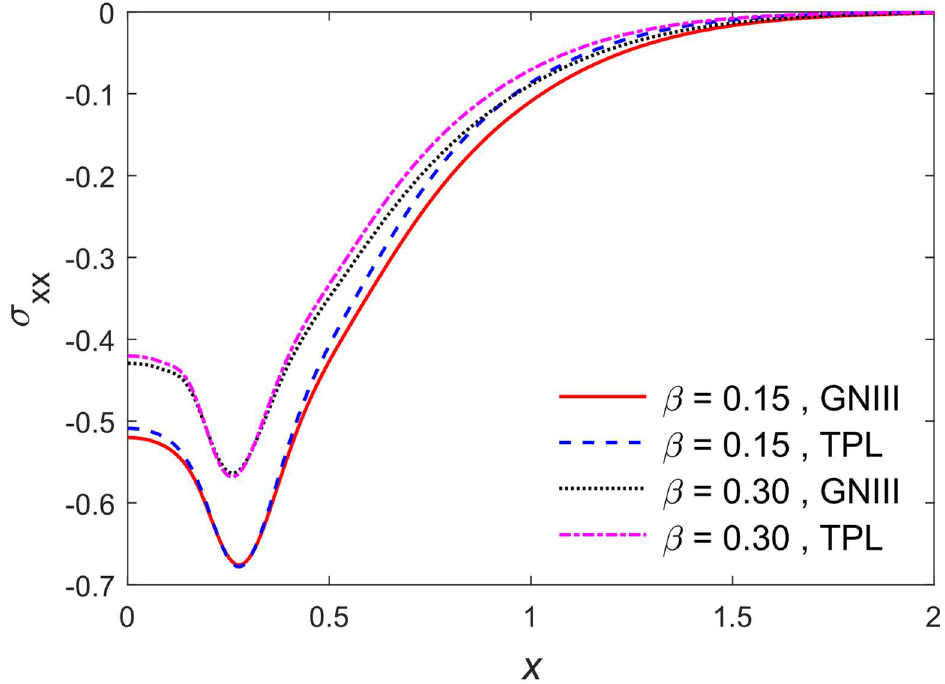
Figure 6. The distributions of solid stress σ xx along the distance x .